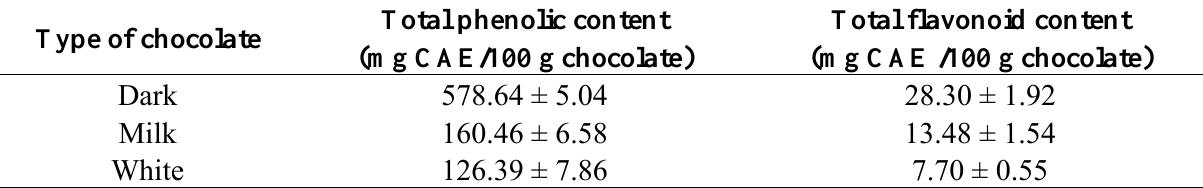
Table 1. Total phenolic and flavonoid contents in different types of commercial chocolates. Type of